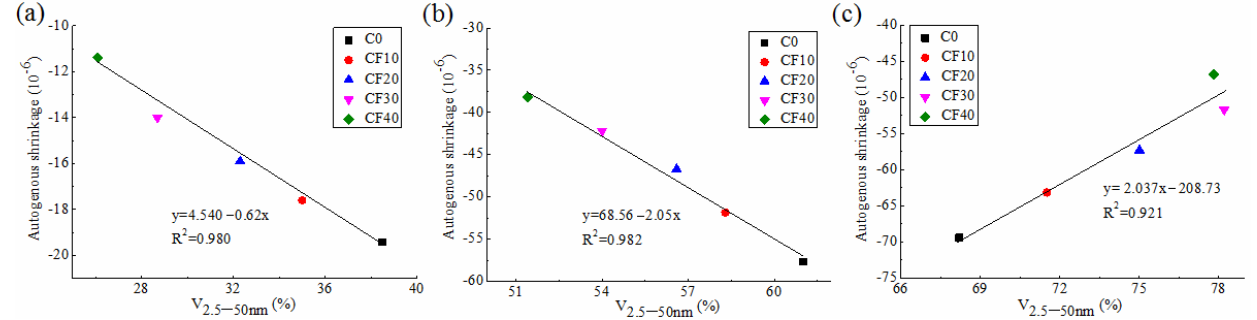
Figure 10. Correlations between autogenous shrinkage and V 2.5–50nm at ( a ) 3 days, ( b ) 28 days and ( c ) 180 days.